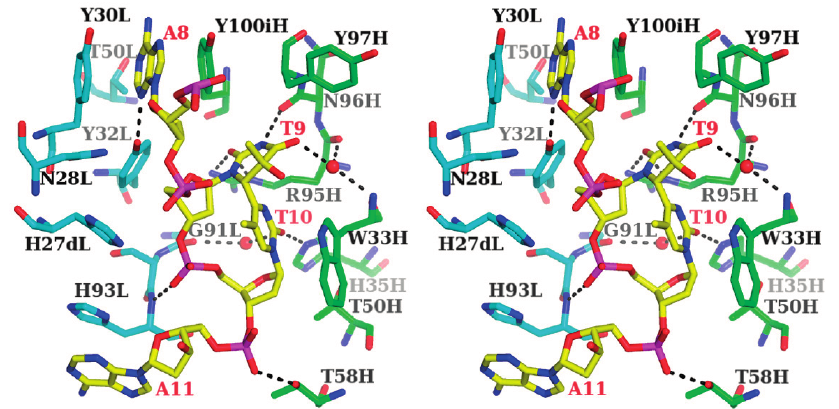
Figure 5. Stereo drawing of the antigen-binding site of the 64M-5 Fab—ds-(6-4) DNA complex (PDB ID: 3VW3). The AT(6-4)TA nucleotide of ds-(6-4) DNA is shown in yellow and labeled in red. The heavy chain of Fab is drawn in green, and the light chain in cyan. Hydrogen bonds are shown in broken lines. T9 and T10 correspond to the T(6-4)T segment. Water molecules are drawn with